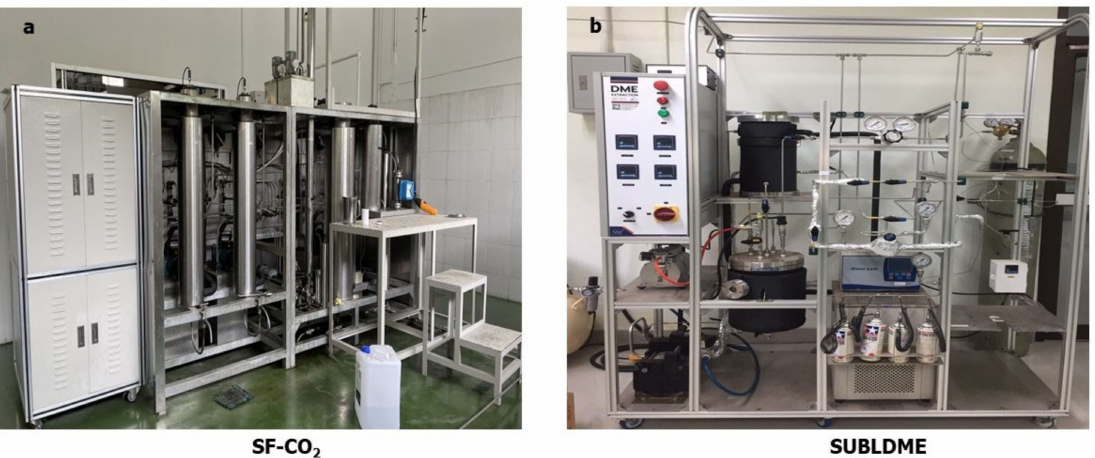
Figure 3. Supercritical fluid carbon dioxide extraction (SF-CO 2 ) ( a ); subcritical liquified dimethyl ether extraction (SULDME) ( b